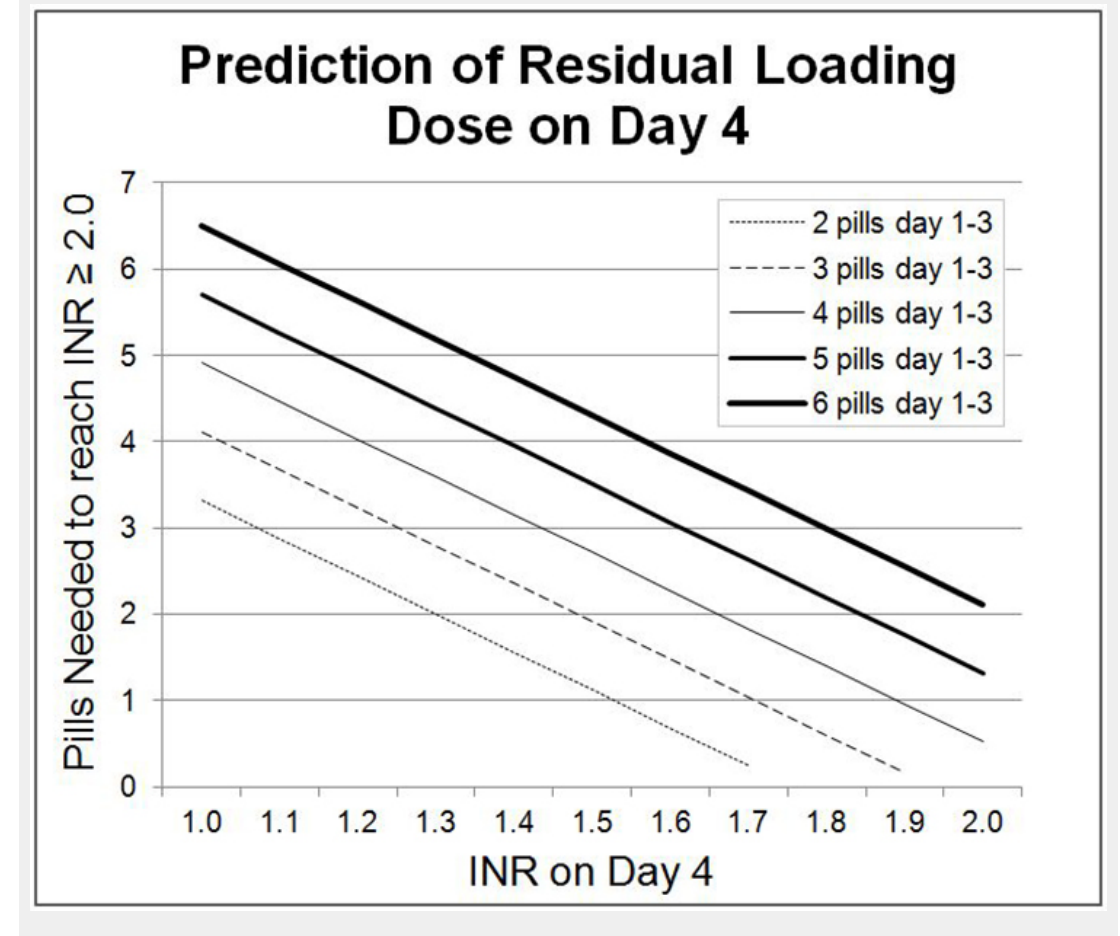
Figure 3 Prediction of residual loading dose on days 4 and